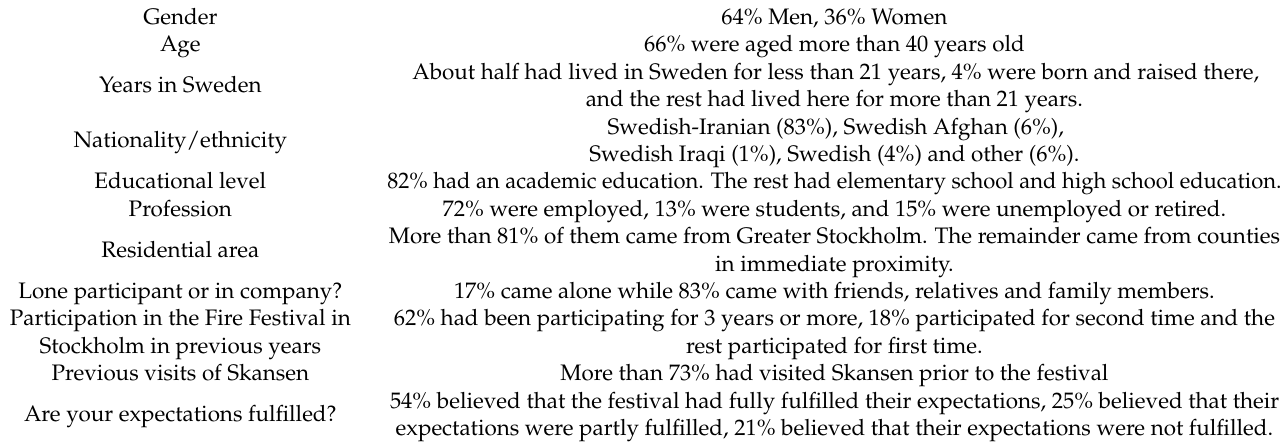
Table 1. Sociodemographic data of the